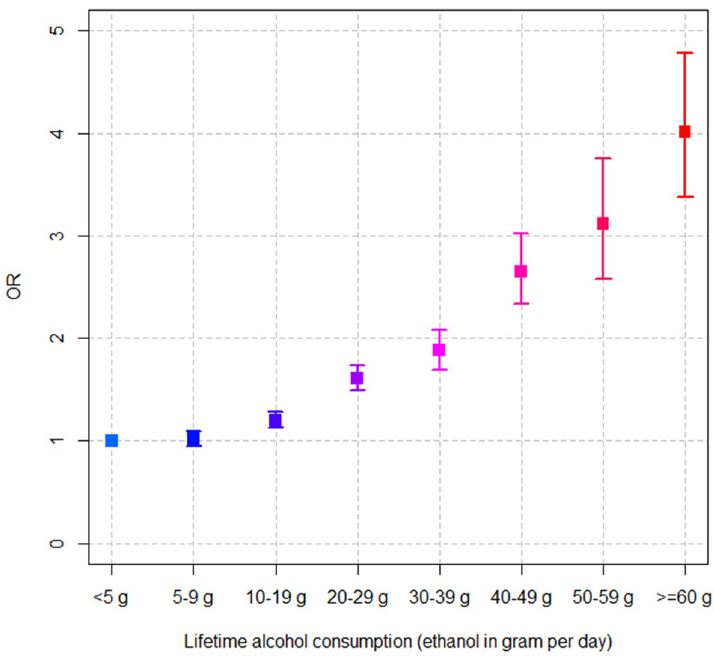
Figure 1. Association between lifetime alcohol consumption and chronic